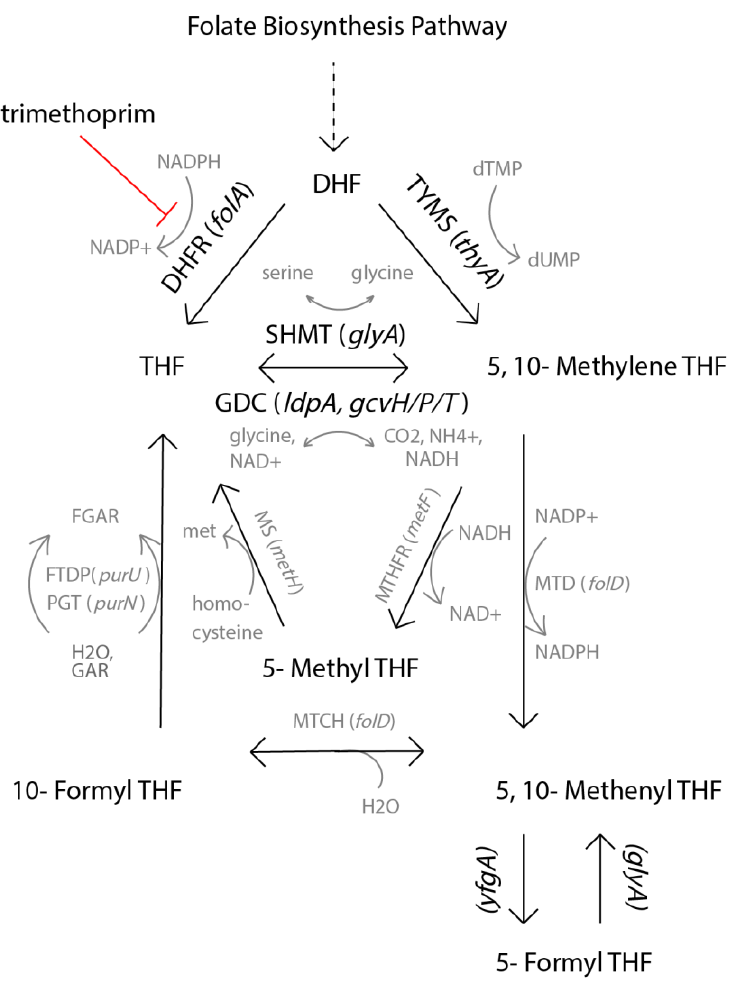
Figure 5. Simplification of the folate biosynthesis pathway. Adapted from Schober et al., Cell Reports (2019). Both enzymes and metabolites are abbreviated: dihydrofolate (DHF), tetrahydrofolate (THF), dihydrofolate reductase (DHFR), thymidylate synthase (TYMS), serine hydroxymethyltransferase (SHMT), glycine cleavage system (GDC). Black text and arrows indicate the steps most important in this genetic context. Genes glyA and gcvH/P/T are significantly downregulated, while ygfA is significantly upregulated.